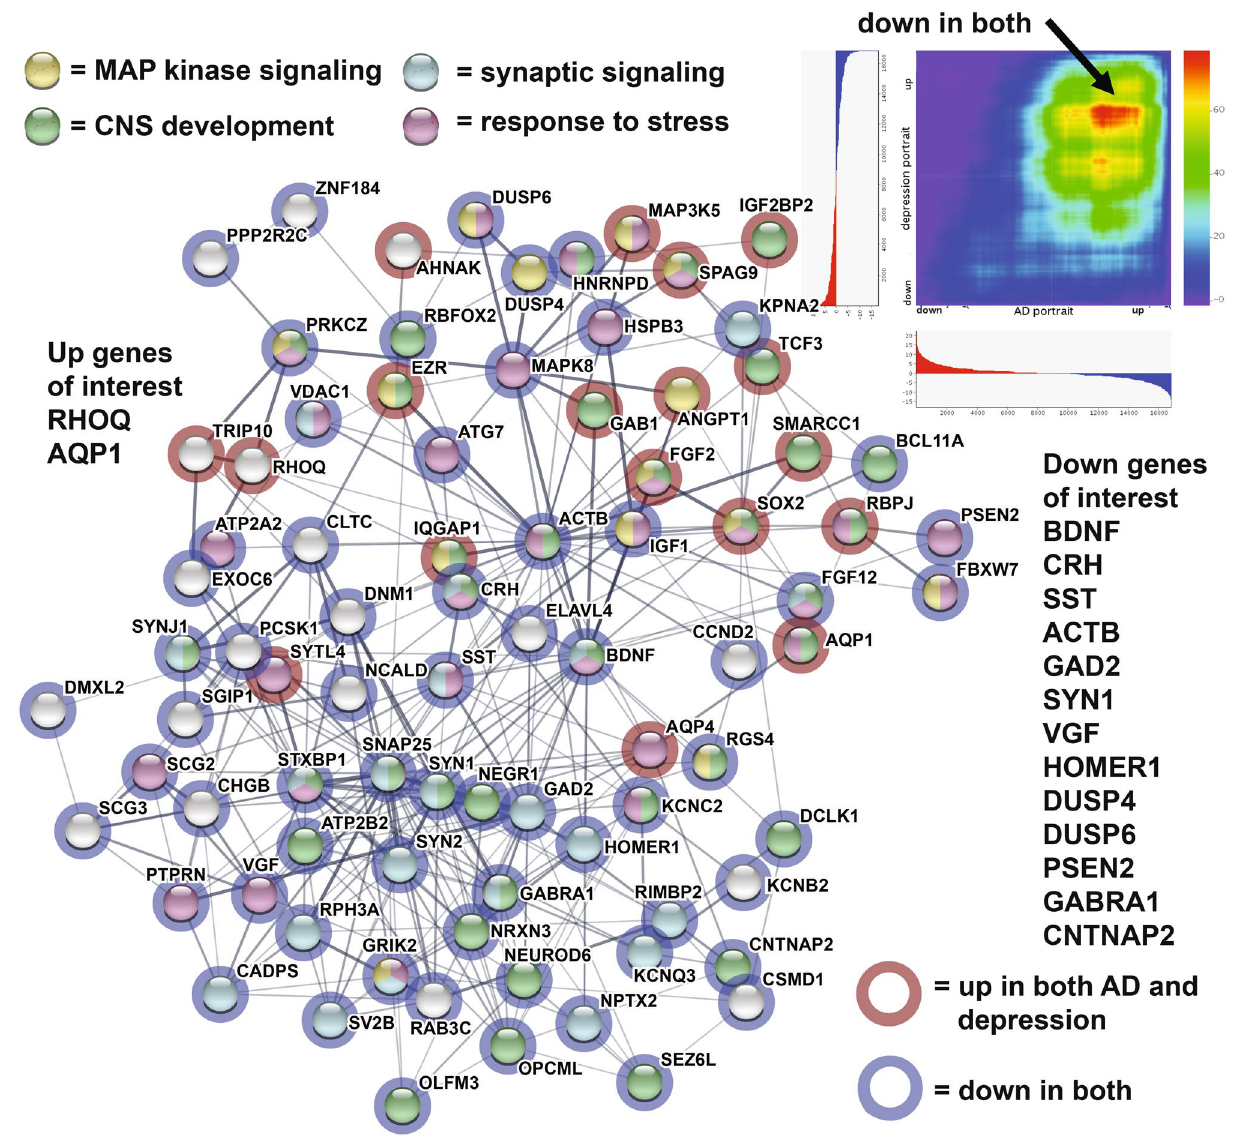
Figure 8. Congruence between AD portrait and depression portrait. Genes with the highest levels of protein–protein interaction (determined via STRING) from the 226 AD genes that match direction in both AD and depression are plotted in STRING 15 . Enrichment was found for: MAP kinase signaling (yellow); CNS development (green); synaptic signaling (light blue); and response to stress (purple). A red halo indicates genes upregulated in AD and depression and a blue halo indicates genes downregulated in both. Common genes of interest include: BDNF, CRH, SST, ACTB, GAD2, and PSEN2. Lines between genes indicates connections and width of line reflects strength of evidence. Upper right shows RRHO heat map 111 for comparisons between depression (Y axis) and AD (X axis) and arrow highlight high congruence of common genes downregulated in both. Details on the axes and colors are same as in Fig.